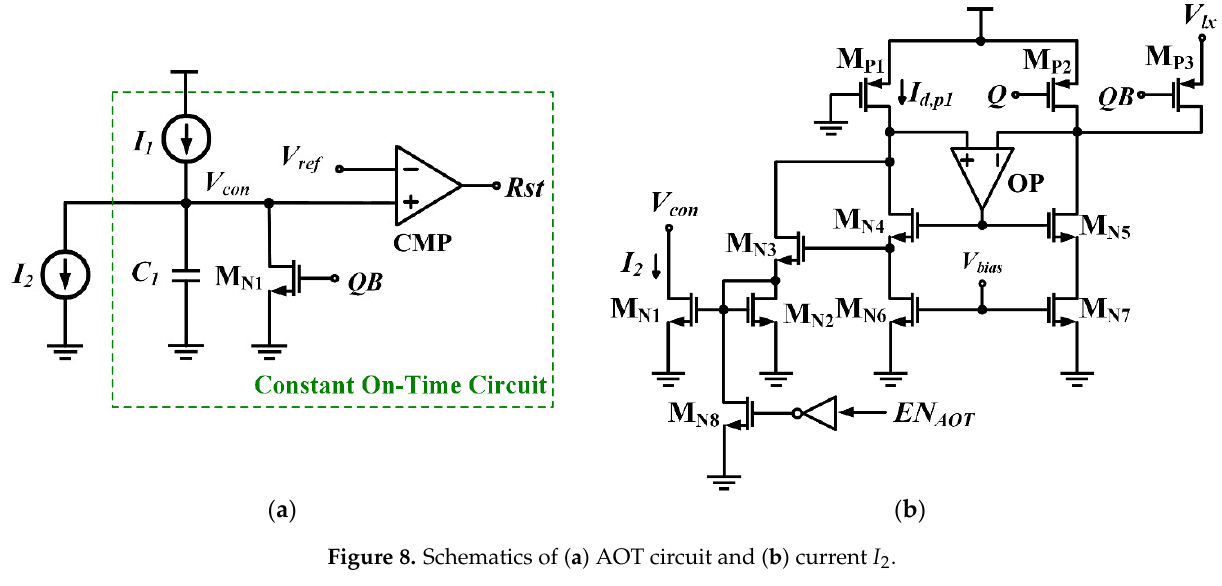
Figure 8. Schematics of ( a ) AOT circuit and ( b ) current I 2 .